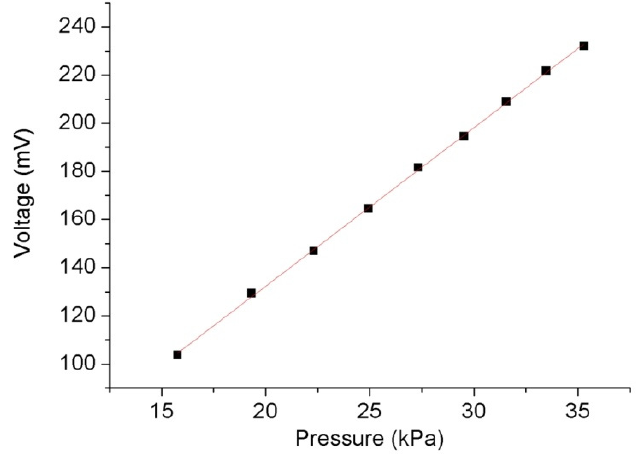
Figure 11. Sensitivity of the sound pressure-output voltage of the FP interference fiber-optic acoustic waver sensor.